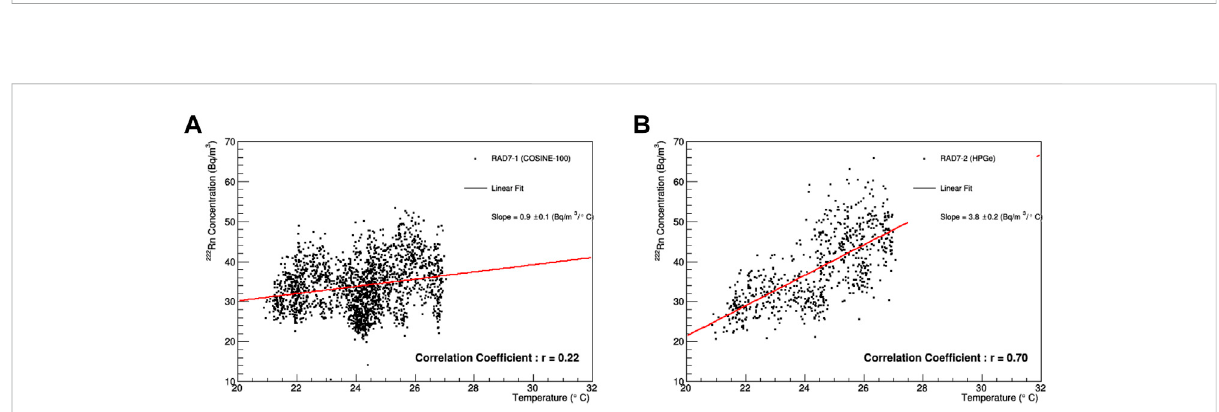
FIGURE 6 The 222 Rn concentrations versusthe tunnel temperature for the COSINE-100 room (A) and the HPGe room (B) . A linear fi thave a slope of 0.9 ± 0.1 Bq/m 3 / ° C and the Pearson correlation coef fi cient is r = 0.22 for the RAD7-1 counter. For RAD7-2, the slope of 3.8 ± 0.2 Bq/m 3 / ° C and the coef fi cient of r = 0.70 are measured. Note that the data analyzed here are from Figure 5 and both RAD7-1 and RAD7-2 measurements include data when RRS is